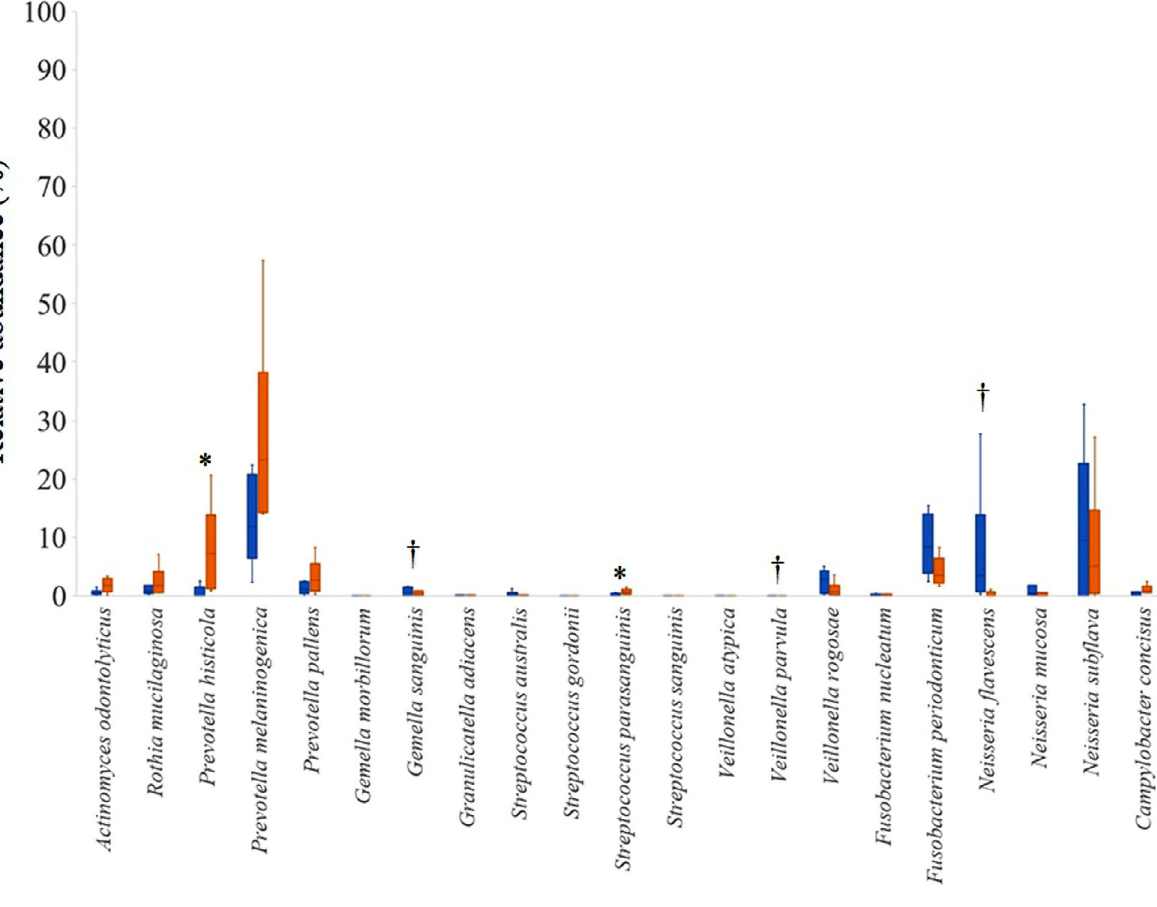
Figure 4- Difference in relative abundance of tongue microbiome between HG and LG. Data were presented as median with error bars representing the 25th and 75th percentiles (n=6/group). These were significant differences in relative abundance of some species between HG (blue bar) and LG (red bar)